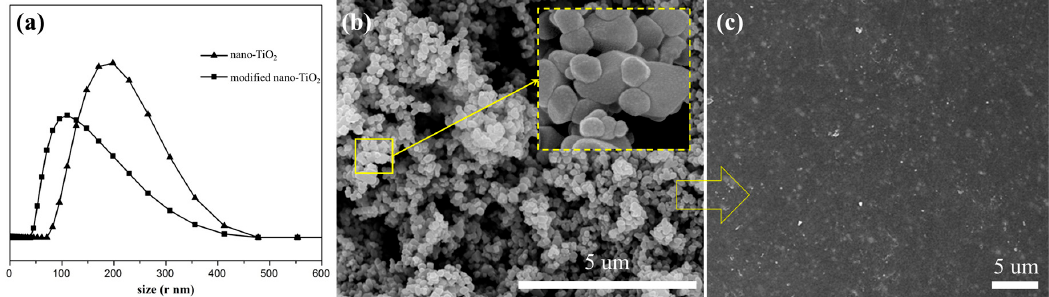
Figure 4. Particle size distribution of nano-TiO 2 before and after modification ( a ), SEM images of modified nano-TiO 2 ( b ), and the surface of PBO fiber containing modified nano-TiO 2 particles ( c ).